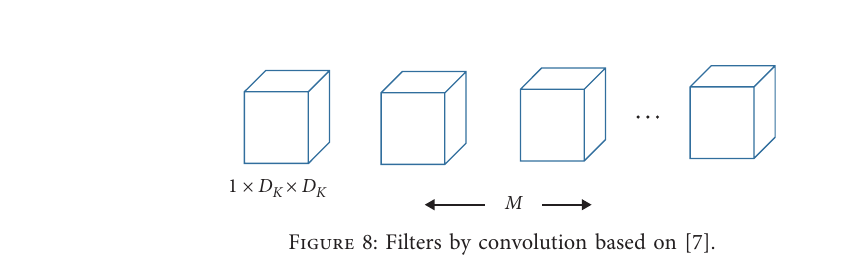
Figure 7: Operation process of MobilenetV2.